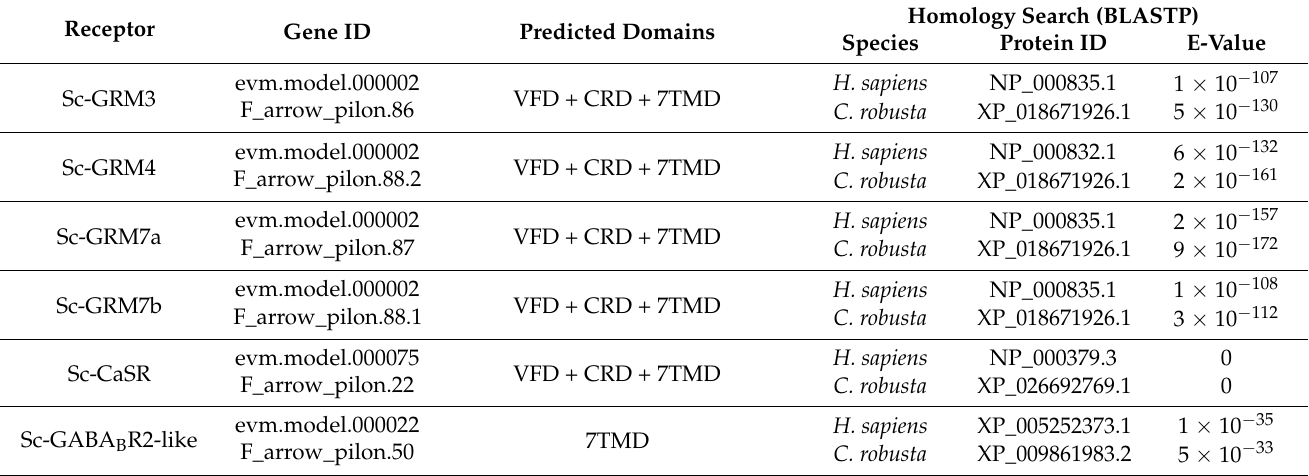
Table 2. The Class C GPCRs identified in the S. clava genome.